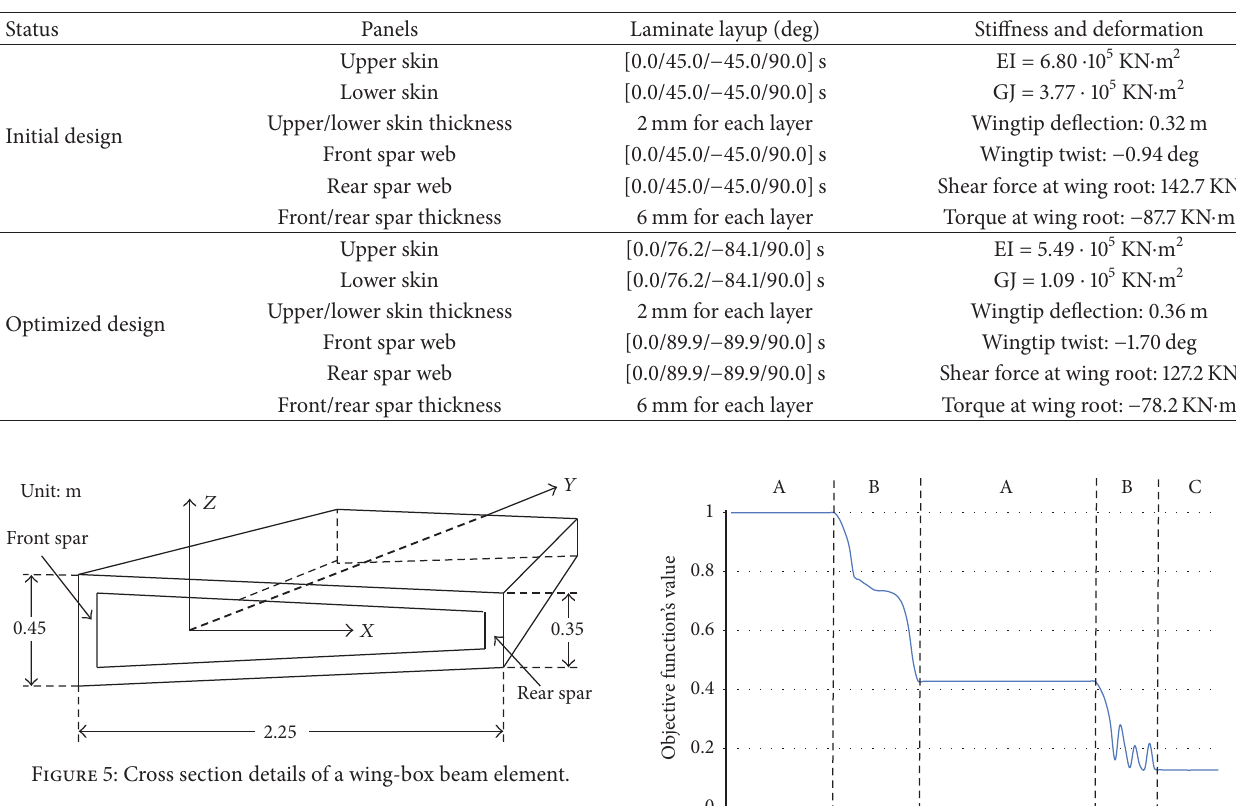
Table 1: Initial and optimized laminate layups, stiffness, and deflection.